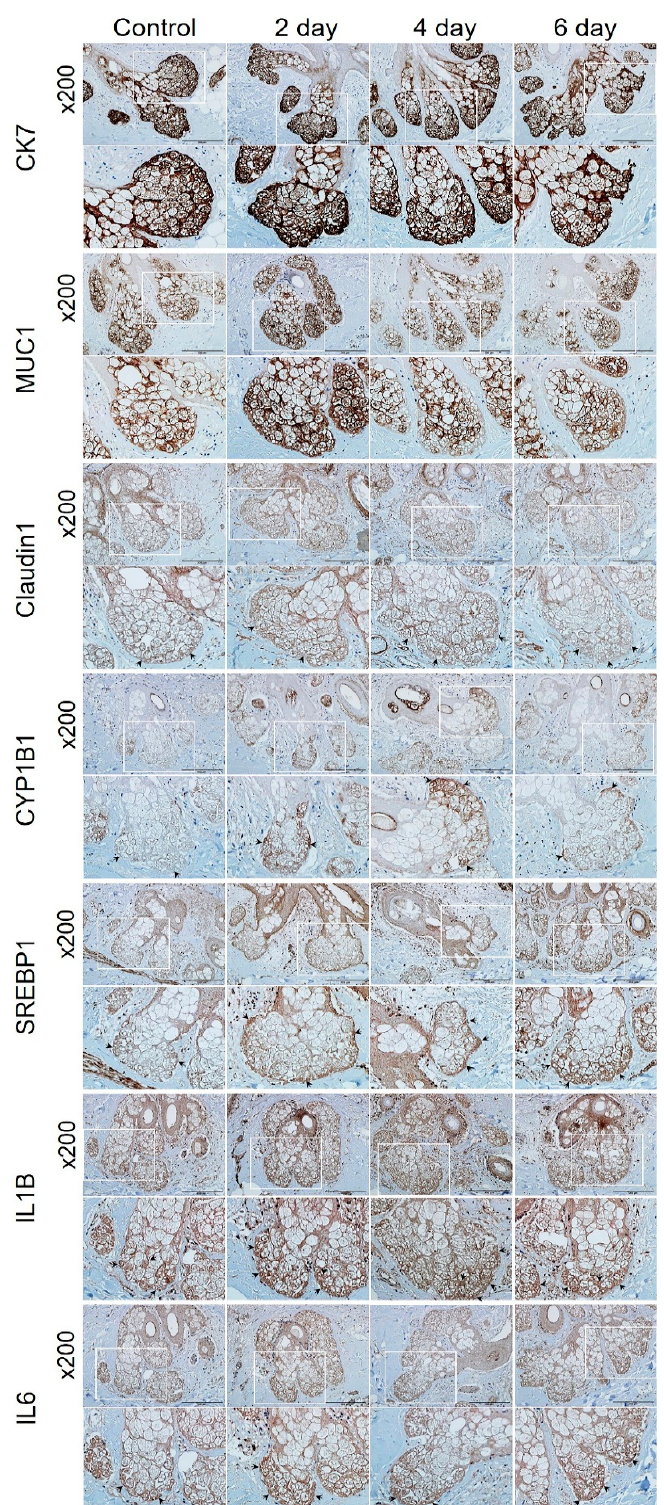
Figure 4. Immunohistochemical analysis of HairSkin ® . HairSkin ® was treated with PM 2.5 (20 μ g/ cm 2 ) for the indicated number of days. HairSkin ® sections were stained with each antibody of cytokeratin 7 (CK7), mucin 1 (MUC1), claudin1, CYP1B1, SREBP1, IL1B, and IL6. Squares marked in white represent the enlarged areas; the arrows point to representative stained regions. Original magnification: 200×. Scale bars: 200 μ m.